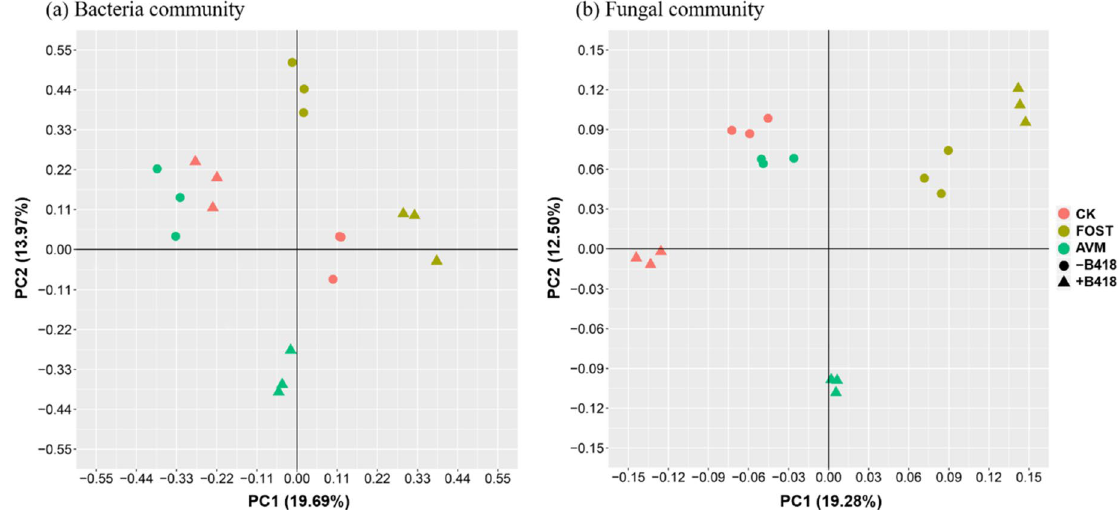
Figure 1. The effects of Burkholderia vietnamiensis B418 inoculation on microbial composition of rhizosphere soil of watermelon. Biplots included principal component analysis (PCA) with weighted UniFrac distances for ( a ) bacterial community and ( b ) fungal community in different treatments. CK: control; FOST: fosthiazate; AVM: avermectin. (+ /−) stands for with and without B418 inoculation.